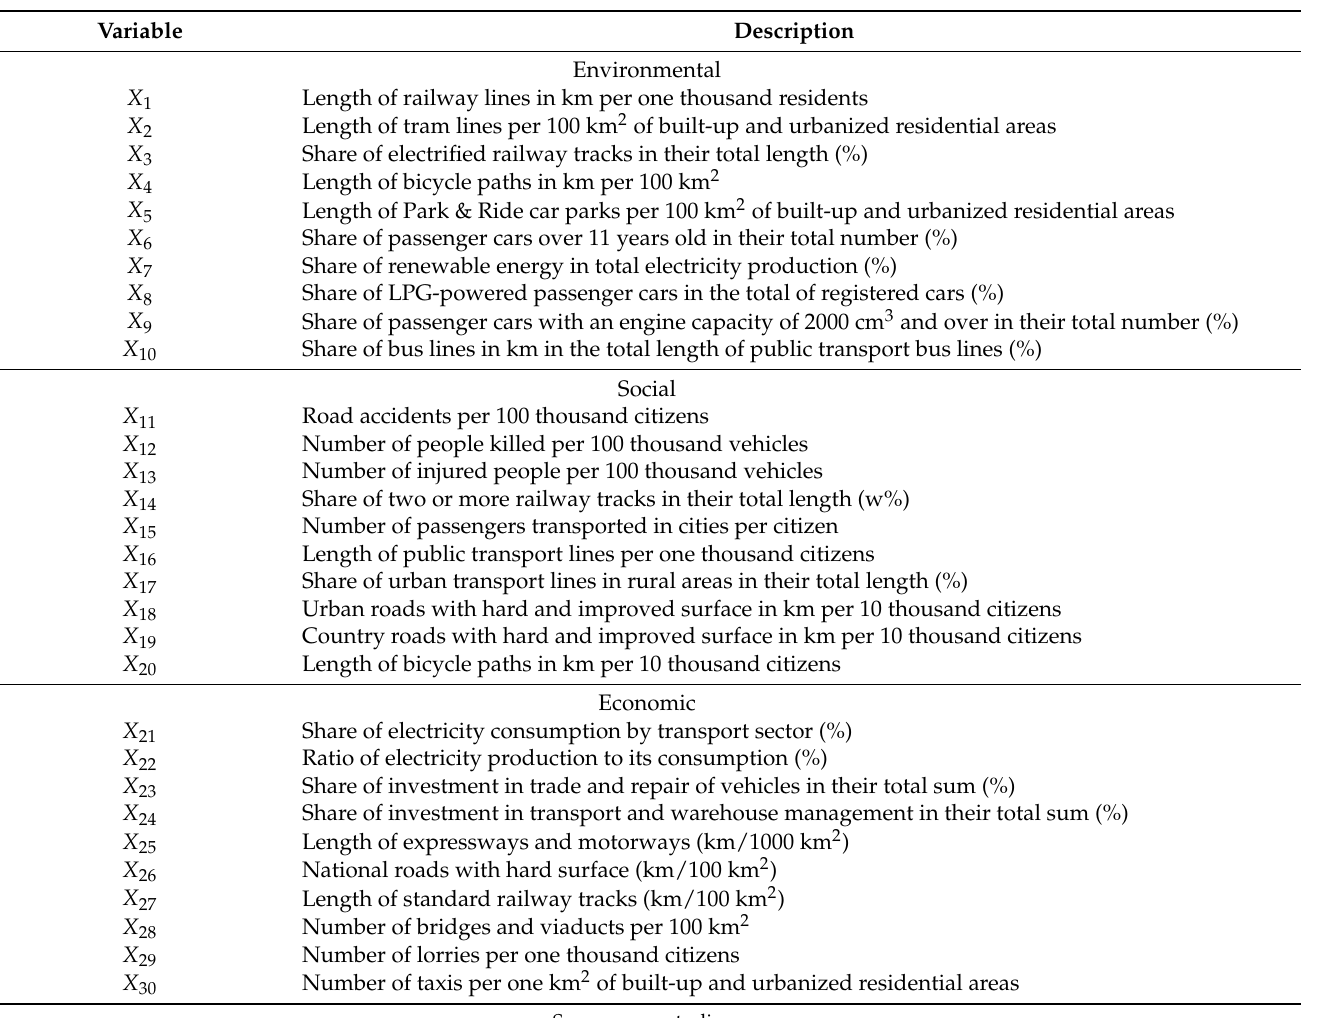
Table 1. Variables used in the